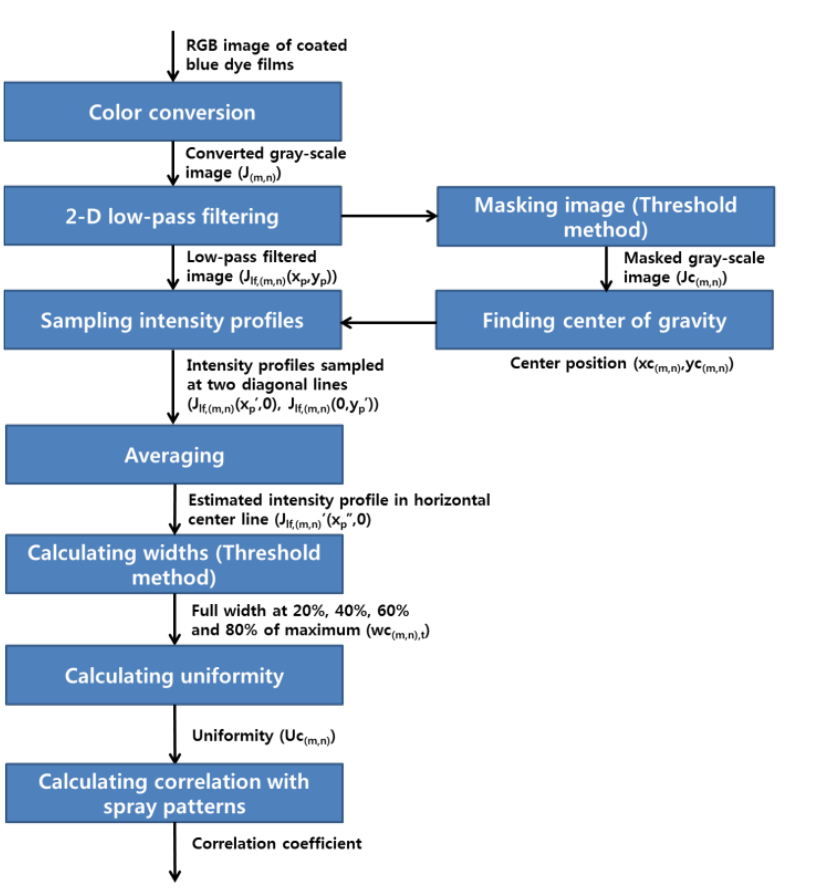
Figure 14. Analysis procedure for the deposited thin